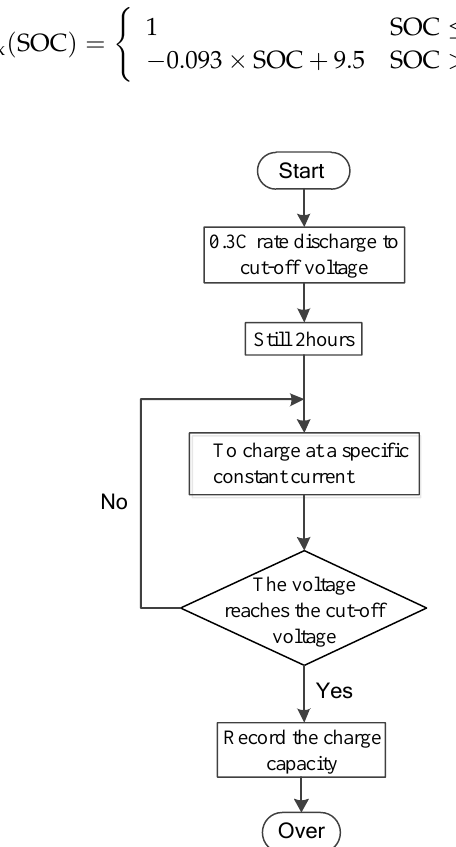
Figure 6. Test flow for the maximum charge capacity with different charging currents.